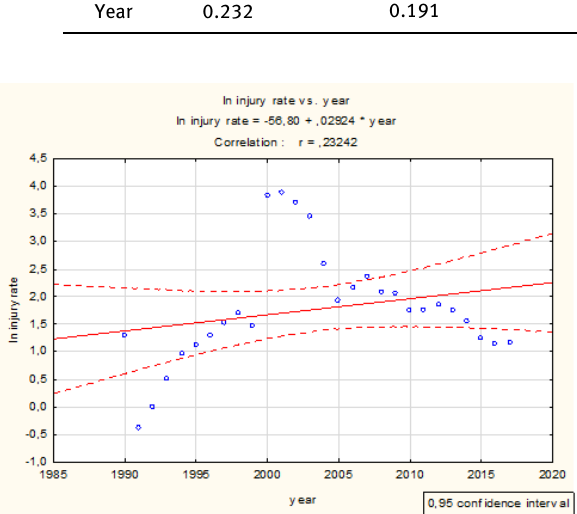
Figure 4: Trend in the injury rate in Slovak state forests (years 2000- 2016) after calculation with model